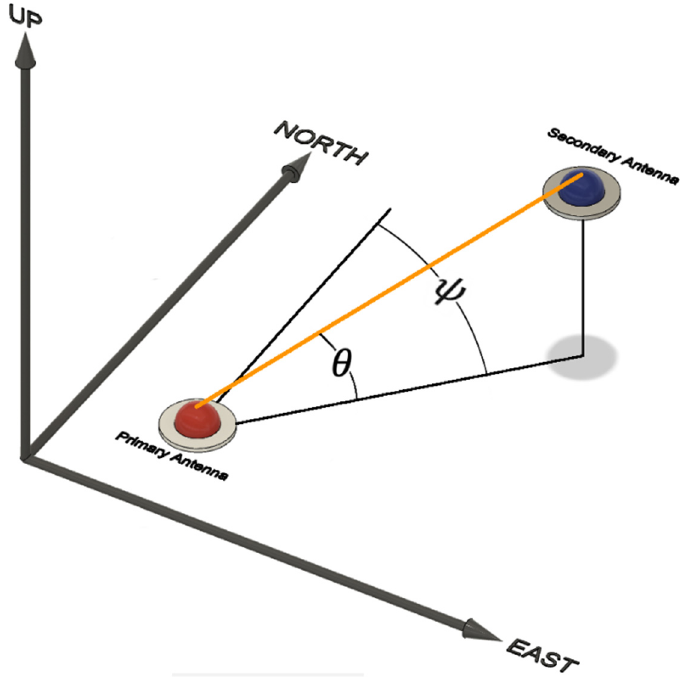
Figure 2. GNSS compass heading ( 𝜓 ) and tilt ( 𝜃 ) angle estimates expressed within a local level (east–north–up) frame.